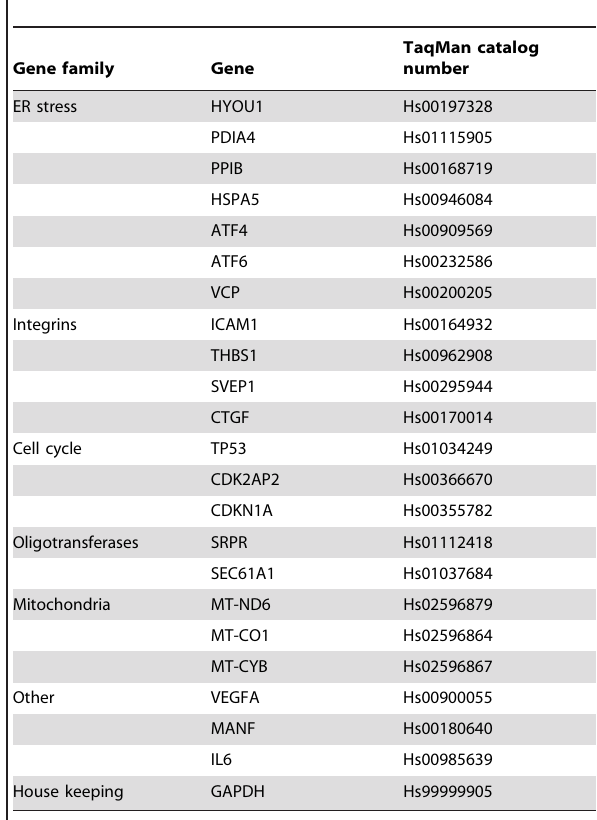
Table 3. TaqMan probes used for the quantification of gene expression by